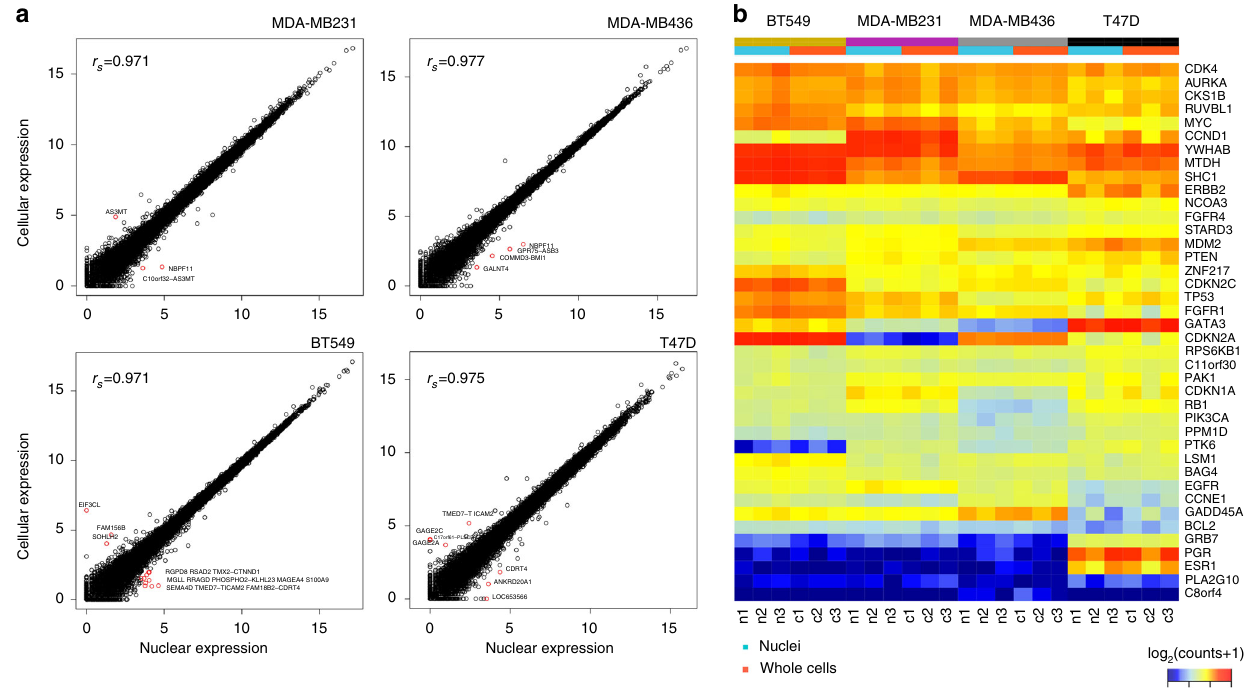
Fig. 1 Bulk nuclear and cellular expression pro fi les from cell lines. a Scatter plots of gene expression [log 2 (counts + 1)] from bulk cellular and nuclear fractions isolated from four breast cancer cell lines. Signi fi cantly differentially expressed genes are highlighted in red and Spearman correlations are indicated. b Gene expression heat map of 40 breast cancer genes identi fi ed in TCGA across three biological replicates of bulk cell and nuclei fractions from the four breast cancer cell